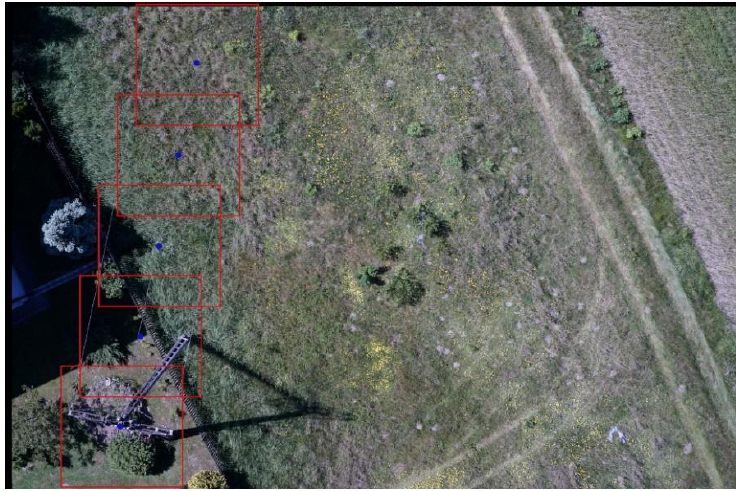
Figure 10. Original image with the calculated image segments in red.